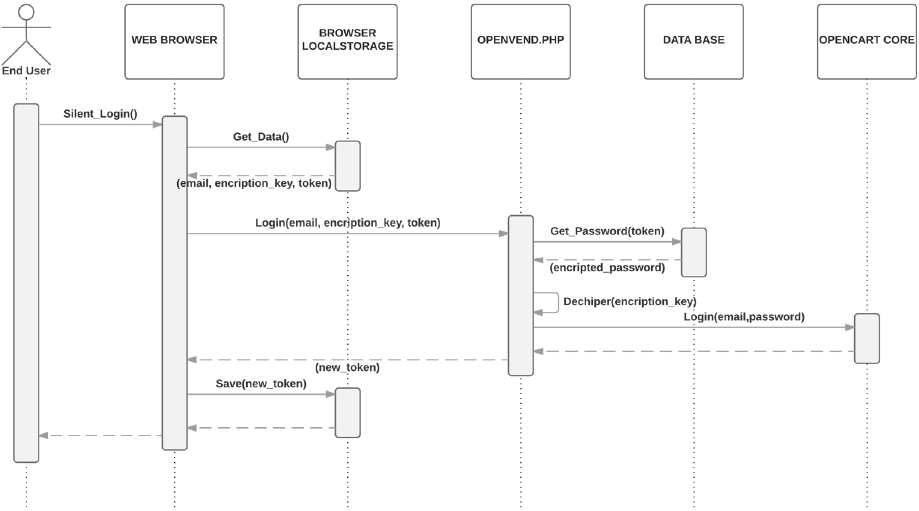
Figure 6. Silent logging process and credentials tokenization.